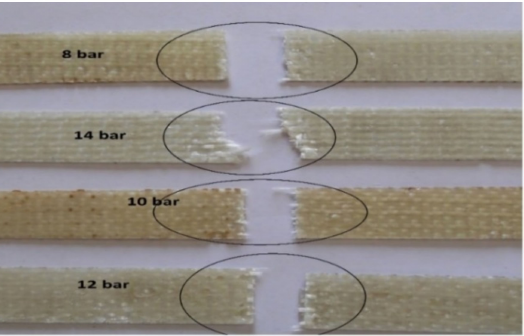
Figure 10. Nature of tensile failure in the 3D woven glass–epoxy composites manufactured with different molding